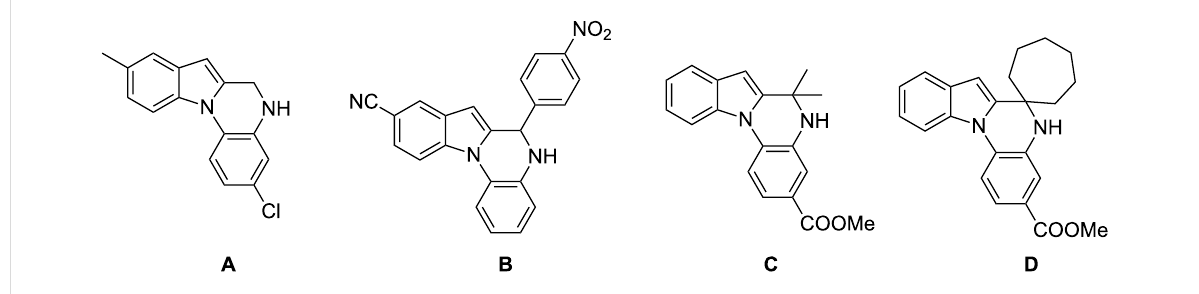
Figure 1: Representative biologically relevant examples of 5,6-dihydroindolo[1,2- a ]quinoxaline derivatives.